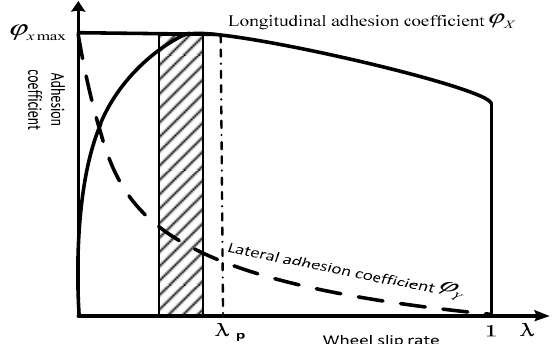
Figure 4. Relationship between adhesion coefficient and slip rate.